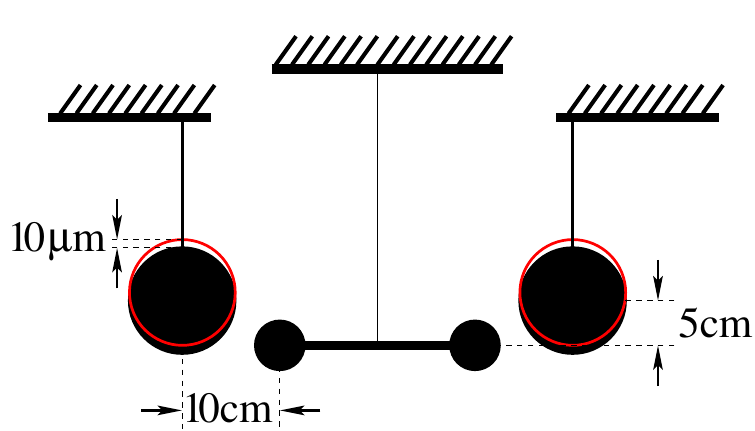
Figure 2. Schematic view of a Cavendish experiment where the delay τ G ∼ 1 ms would shift the 5 th digit of the measured G by −